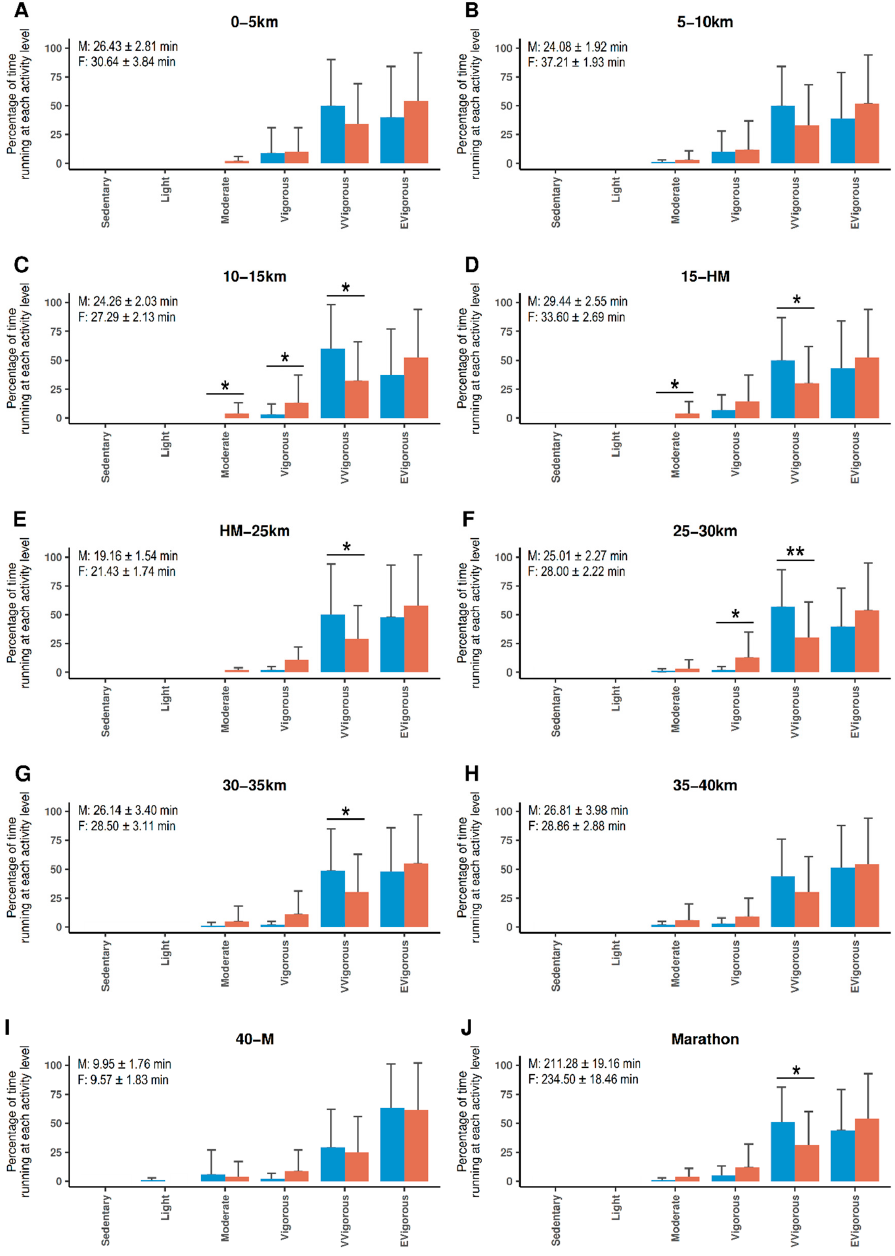
Figure 1. Bar plots showing the percentage of time performing at each of the six-relative intensity levels of physical activity. Running intensity distribution was analyzed ( A – I ) in each one of the nine race sections, and ( J ) for the whole marathon distance. Bars represent the average values for males (orange) and females (blue), and error bars represent the standard deviation of the mean. Mean time spent ( ± standard deviation) to cover each race sections and the whole race by males (M) and females (F) is showed in the corresponding panel. A Mann–Whitney U test was used for testing sex di ff erences. * p -value < 0.05; ** p -value <